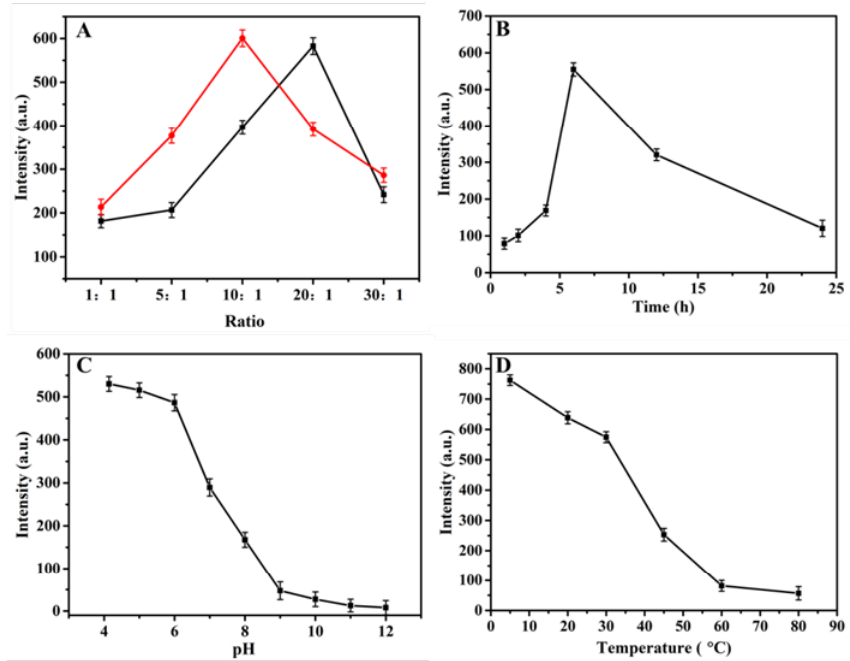
Figure 4. Optimization results of ( A ) the molar ratio of LA and Cu 2+ (black line) and the ratio of LA − Cu NCs solution volume to CS (red line), ( B ) reaction time (25 °C), ( C ) pH value and ( D ) reaction temperature (reaction time: 6 h).